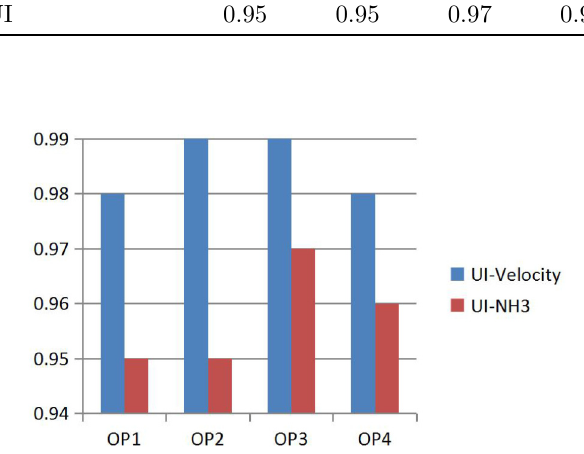
Fig. 12. Statistics of uniformity index under four operating